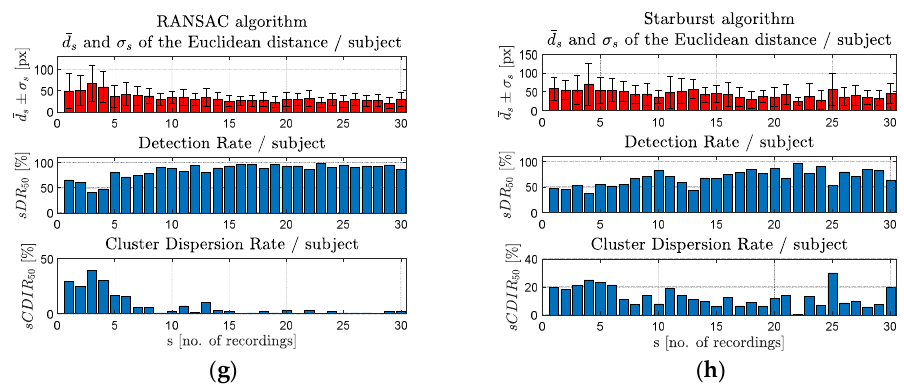
Figure 13. Experimental results obtained on the video eye images for the ( a ) CENT, ( b ) CHT, ( c ) EHT, ( d ) ExCuSe, ( e ) LSFE, ( f ) PROJ, ( g ) RANSAC, and ( h ) Starburst algorithms.